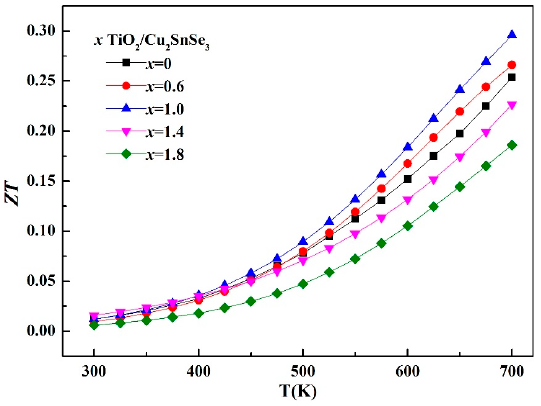
Figure 10. Temperature dependence of ZT for TiO 2 /Cu 2 SnSe 3 composites.